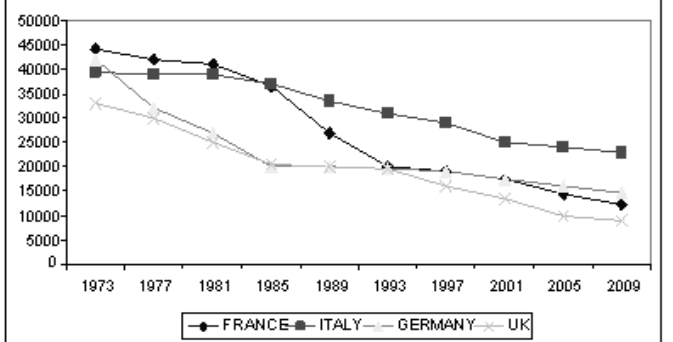
Figure 8: Number of Fuel Retail Sites in Selected European Countries – 2009